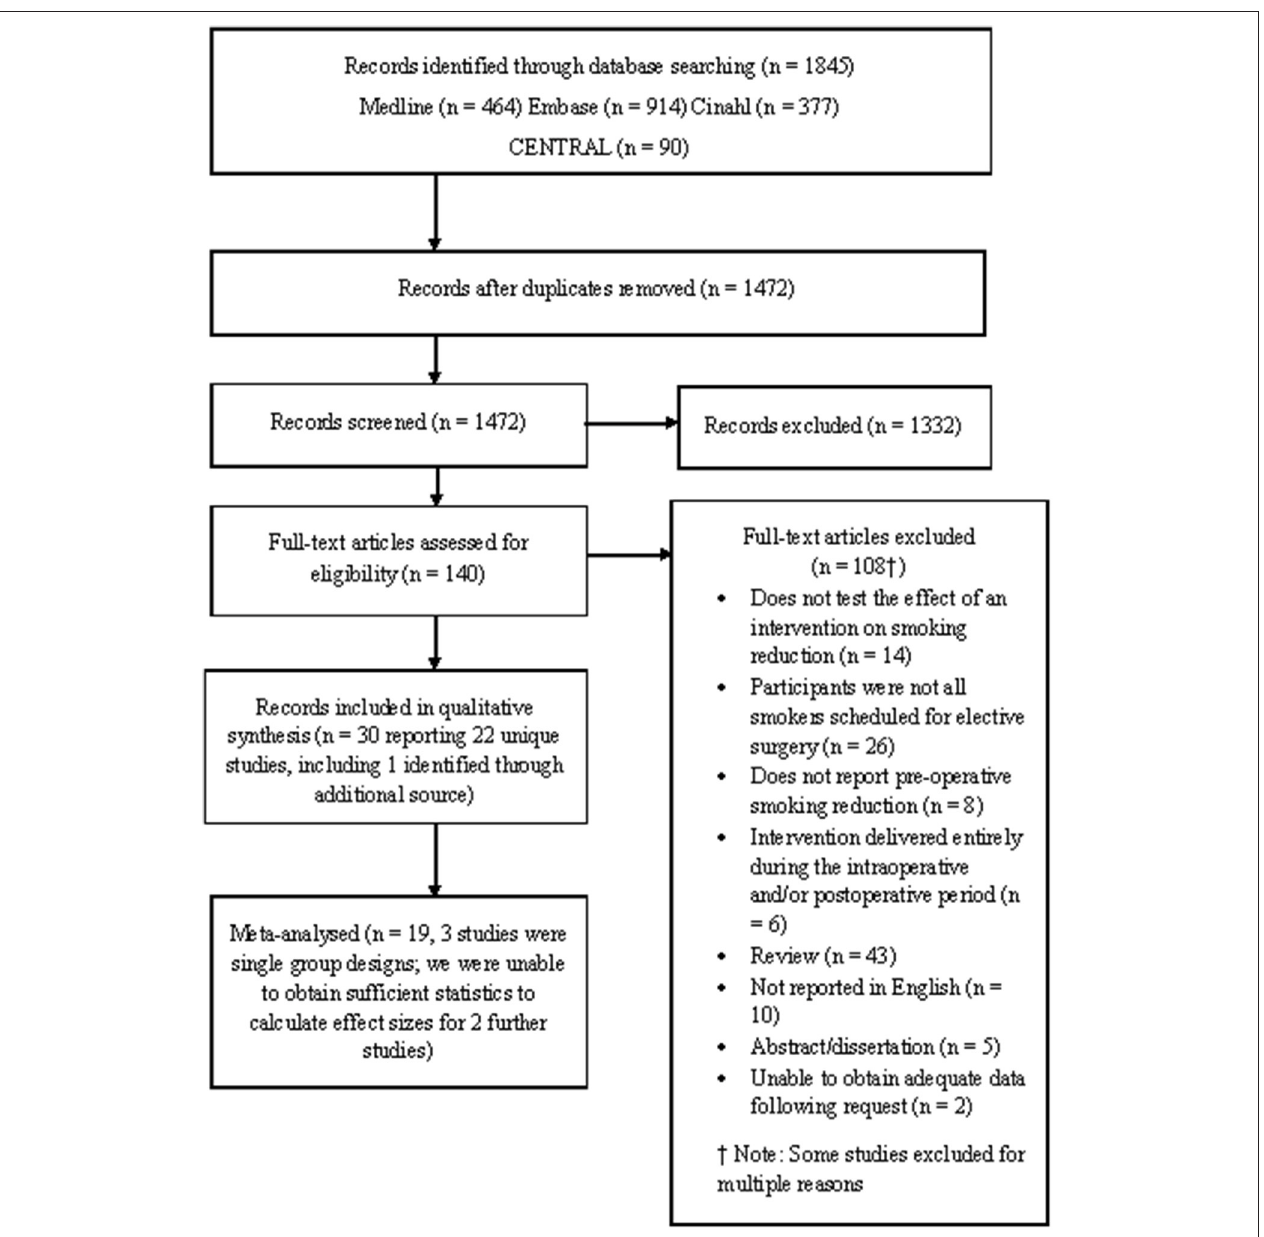
FIGURE 1 | PRISMA Flow